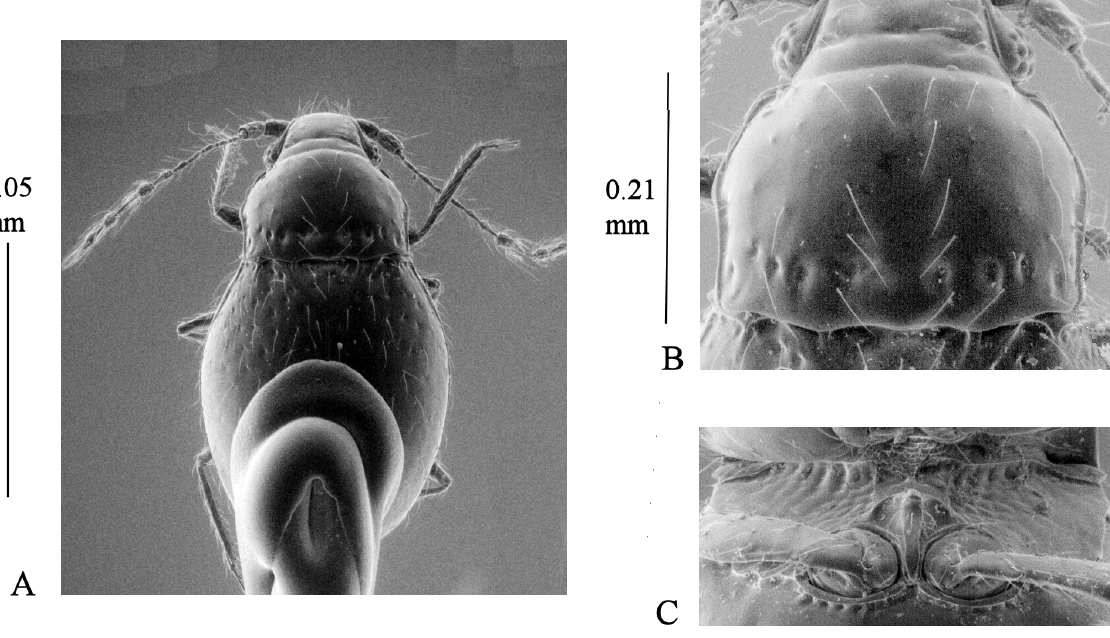
Fig. 38. Cissidium okuense Grebennikov, 2009. A . Habitus. B . Pronotum, C . Mesoventrite (fore shortened by camera position, SEM images provided to me by V.